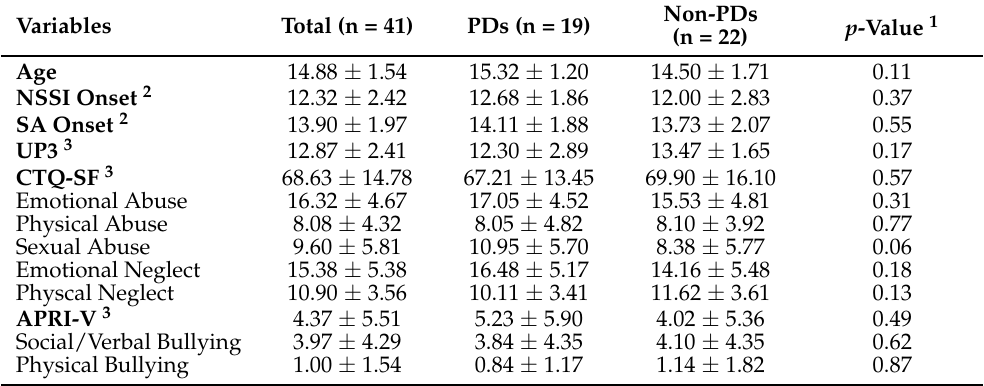
Table 2. Comparisonoffeaturesinsubgroupsself-harmofpatientswithandwithoutpersonalitydisorders.